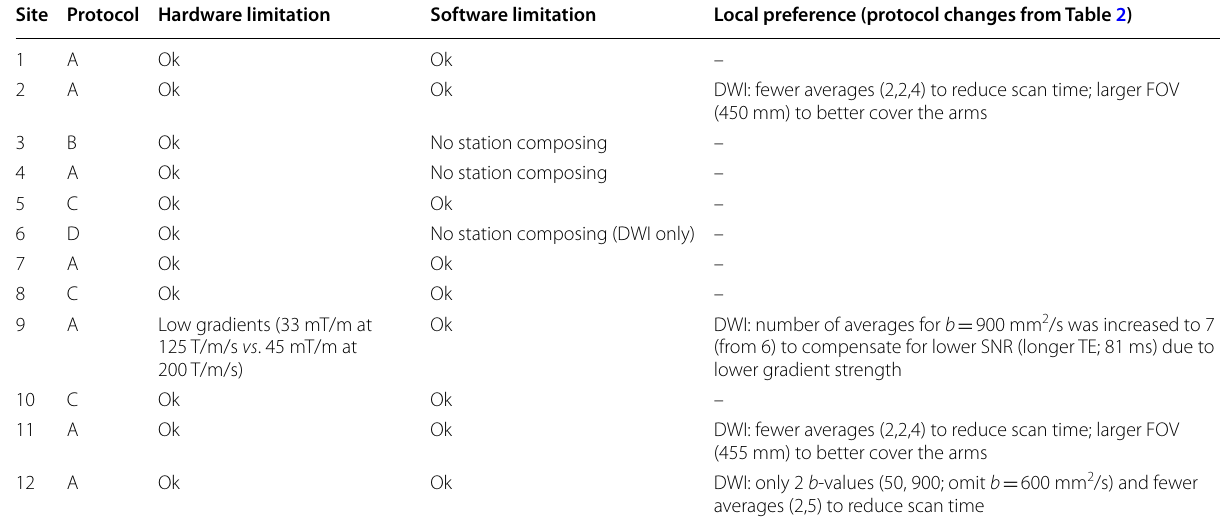
FOV field of view; SNR signal-to-noise ratio